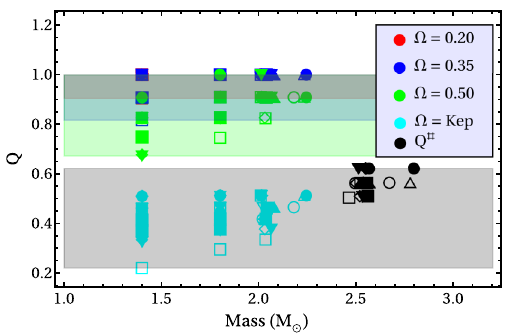
Fig. 6 The plot of Q is a function of the mass has been shown. The mass is in the units of solar mass M (cid:8) and has been plotted for mass ranging from 1 . 0 M (cid:8) to 2 . 79 M (cid:8) constructed with 18 HYB EoS. The Q for stars having a particular rotational velocity lies in a band, and its width increases with an increase in rotational